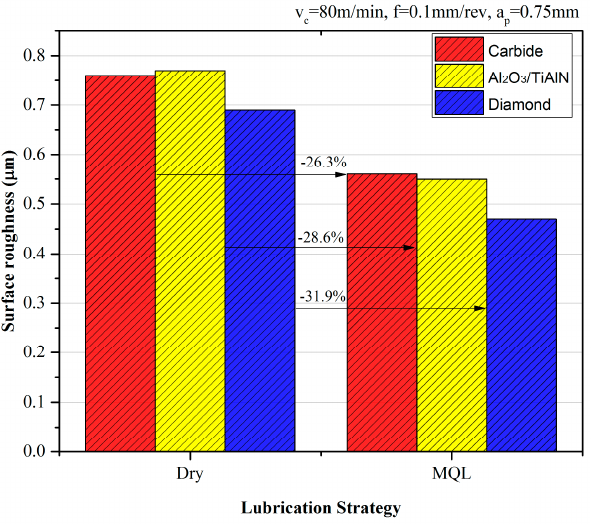
Figure 13. Surface roughness comparison for different tools under dry and MQL conditions.